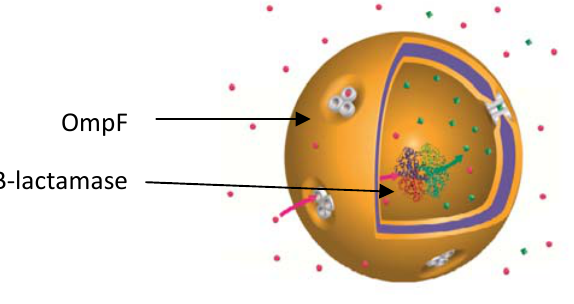
Figure 7. Schematic representation of a polymeric vesicle containing enzymes and reconstituted channel